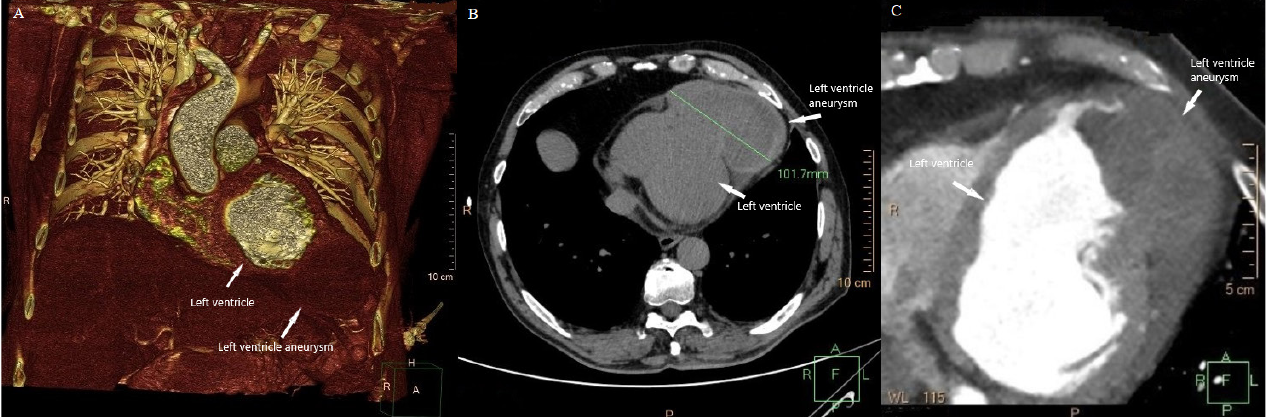
Fig. 1 - ECG-gated cardiac CT. (A) 3D volume rendering reconstruction – well-defined aneurysmal sac in the antero-inferior lateral aspect of the left ventricle. (B-C) Axial view of unenhanced and contrast-enhanced phase – active contrast extravasation into the aneurysmal